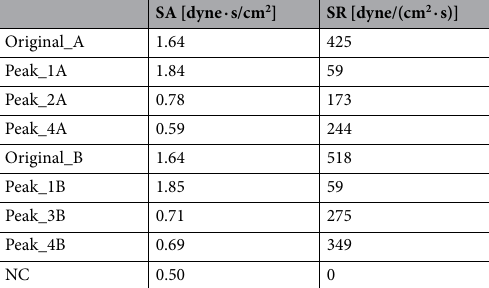
SA [dyne · s/cm 2 ] SR [dyne/(cm 2 · s)]